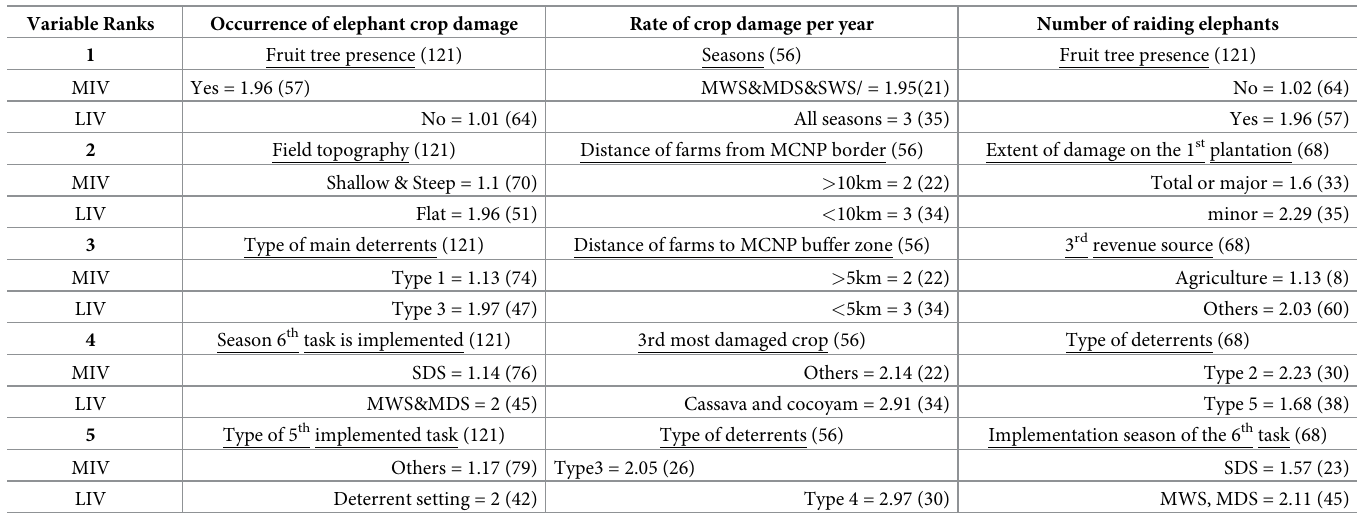
Table 1. CART results from farmer